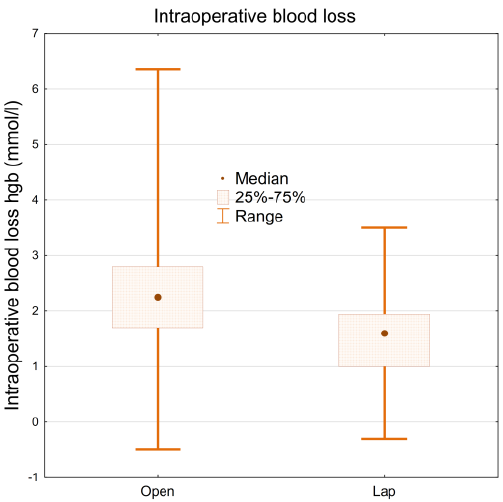
Figure 2. Intraoperative blood loss ORC vs.